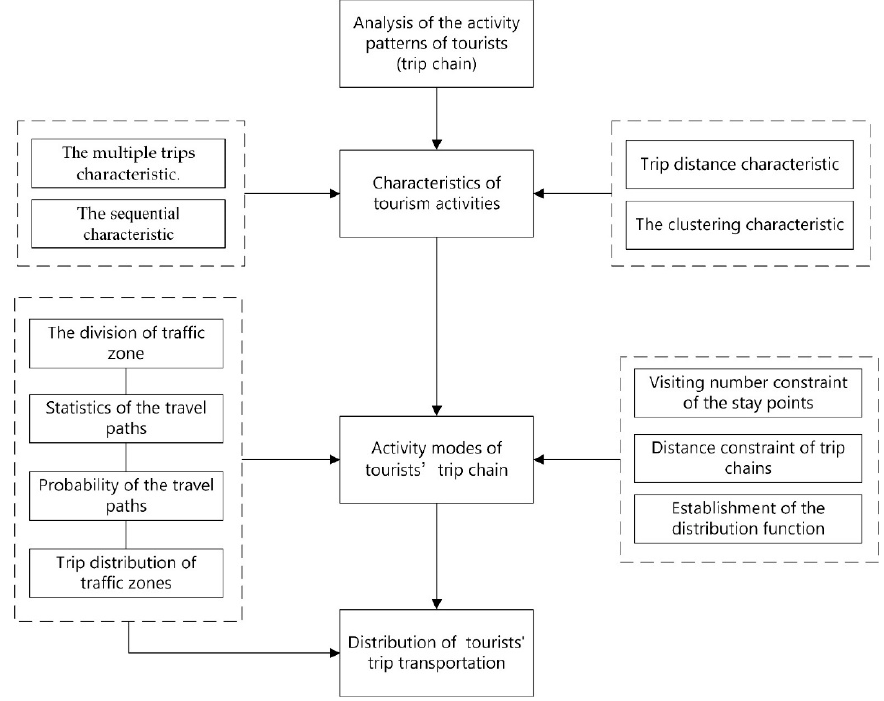
Figure 2. The basic idea for the tourist trip distribution modeling.